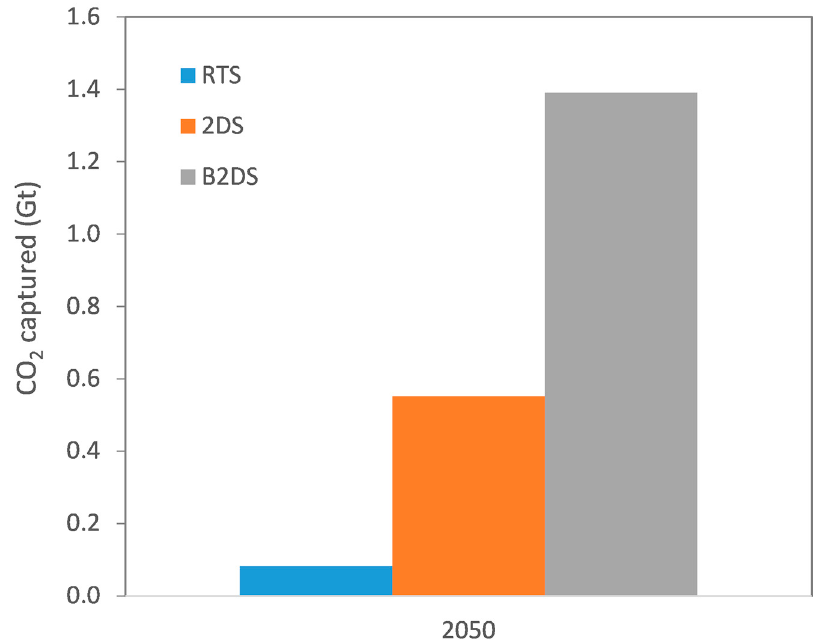
Figure 3. Global direct CO 2 emissions from the cement sectors captured annually according to different IEA scenarios (data taken from [3]).